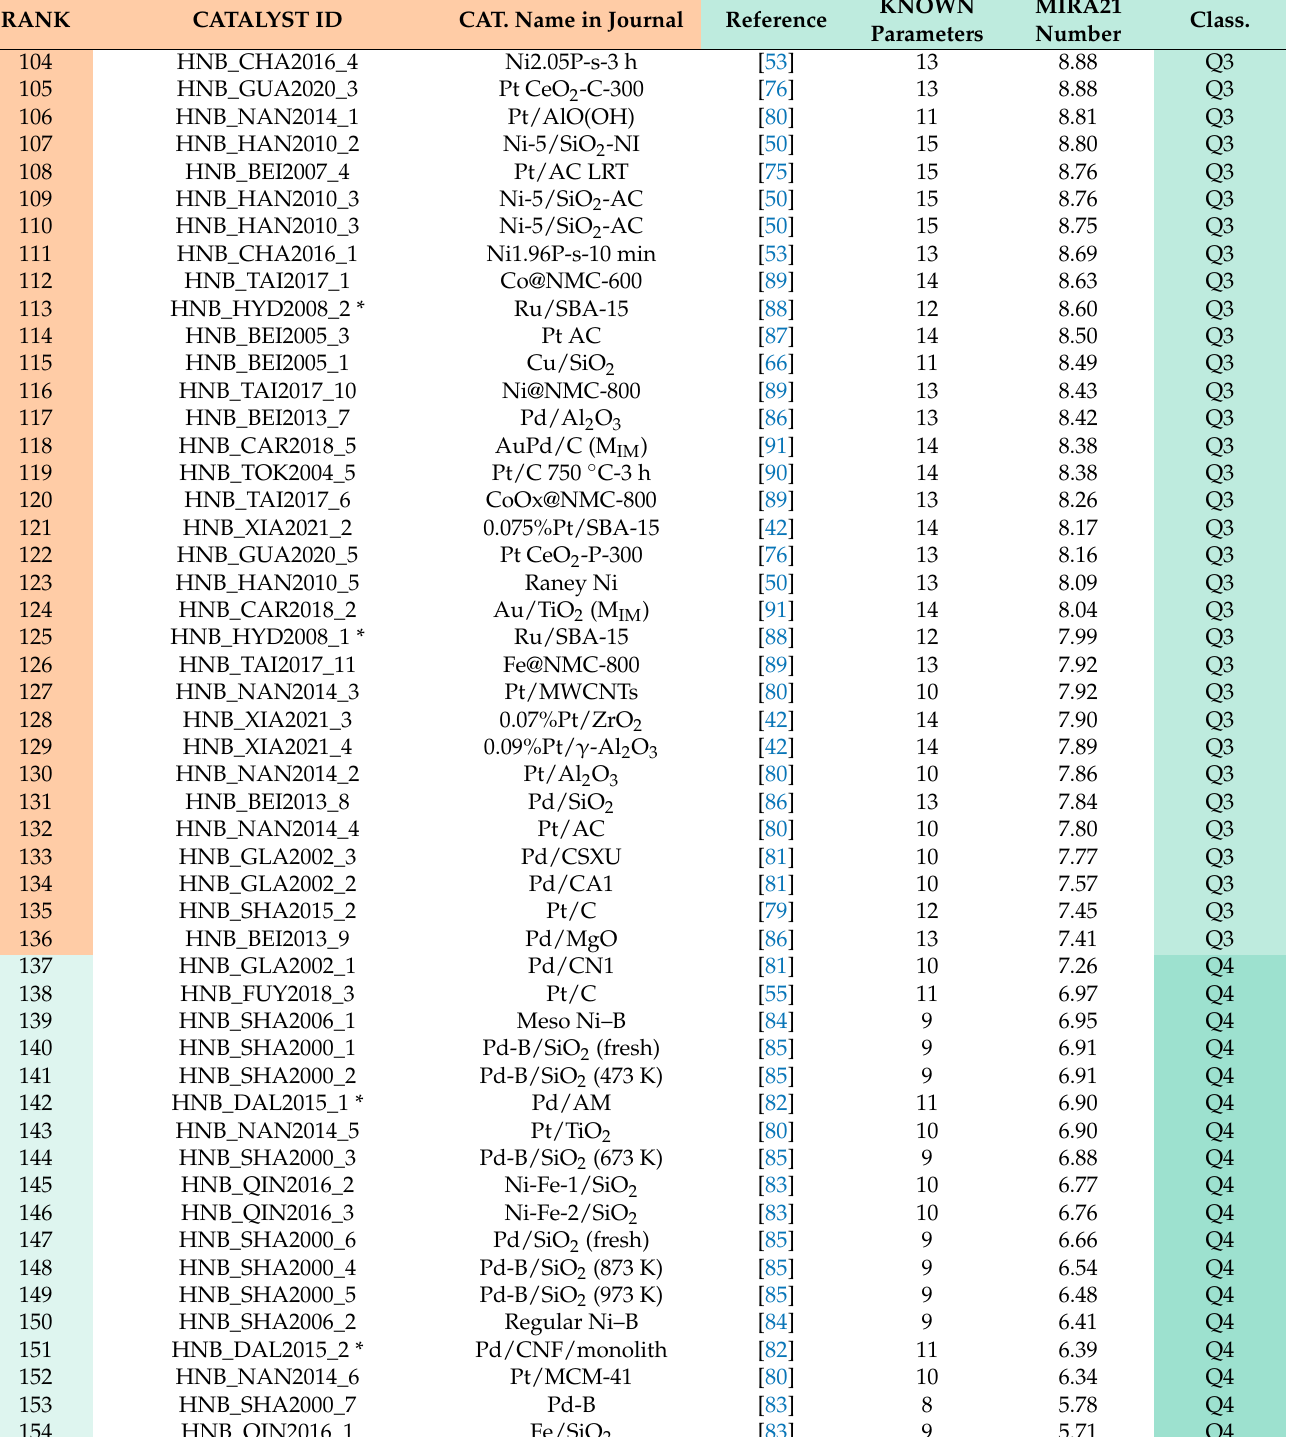
Table 6. List of Q3 and Q4 catalysts according to